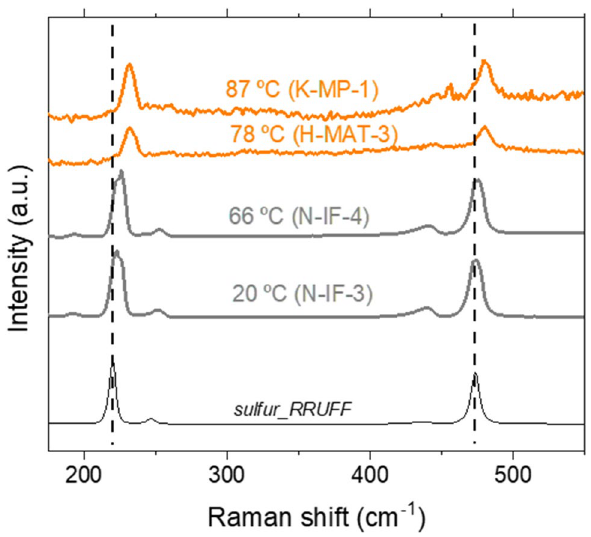
Figure 2. Raman spectra of selected sample spots where elemental sulfur was detected and its relationship with temperature. At the bottom, the sulfur Raman spectra from the RRUFF database are shown to compare and identify the shifts of the vibrational modes of sulfur according to the increase in temperature. For sample naming codes see Supplementary Table S1